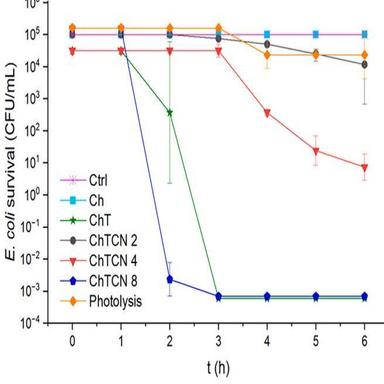
Photocatalytic inactivation of E. coli in distilled water under visible light. The error bars represent the standard deviation (n = 3).